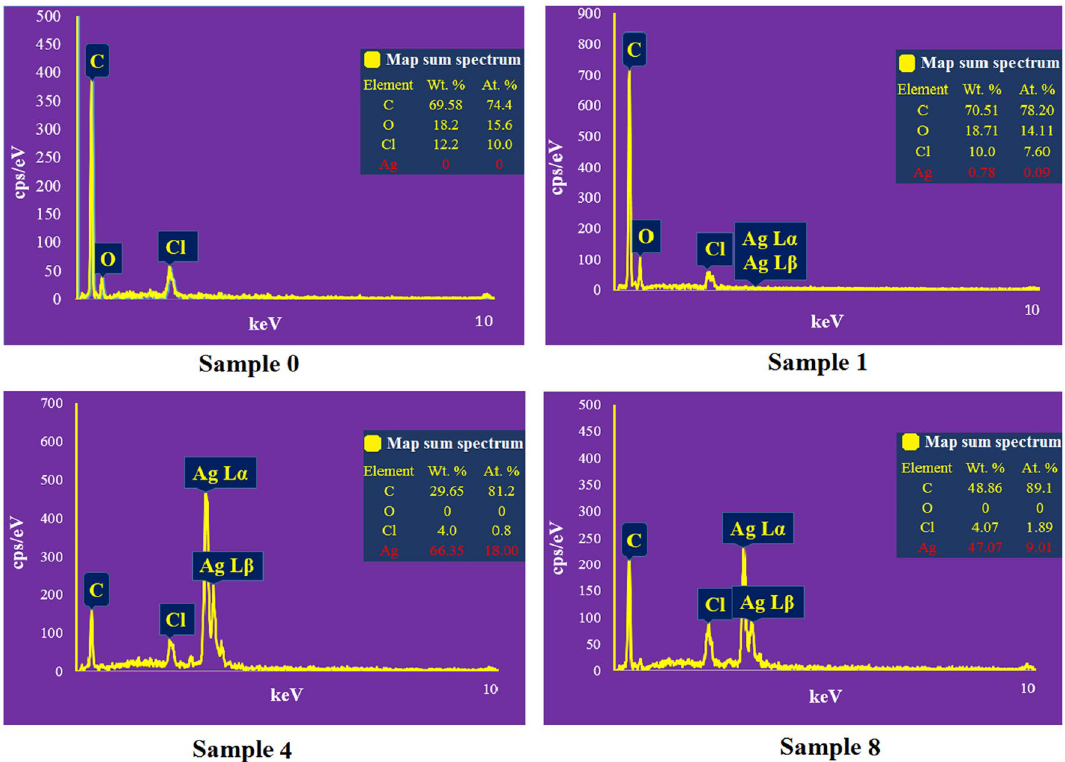
Figure 4. EDX spectra of the uncoated and coated samples indicating the presence of SNPs on the coated fabrics. Sample 0 (Uncoated fabric), Samples 1 and 4 (NS-coated fabrics at 2 and 50 mM silver nitrate concentrations, and 25 min sonication time, respectively), Sample 8 (NS-coated fabrics at 50 mM silver nitrate concentration and 50 min sonication time).